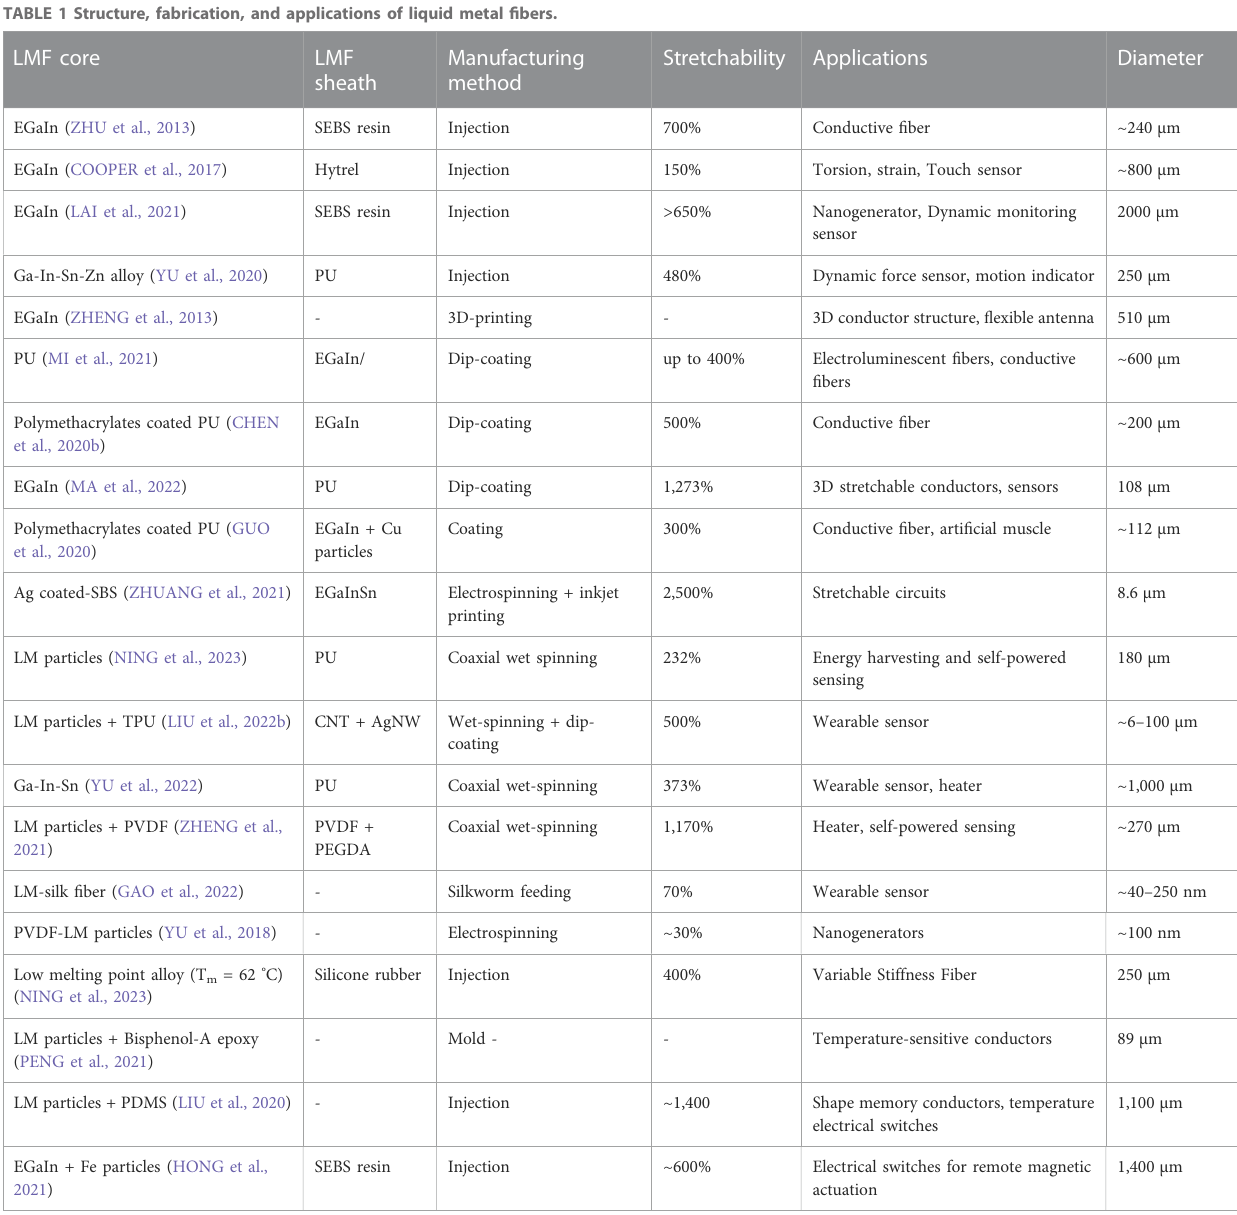
TABLE 1 Structure, fabrication, and applications of liquid metal fi